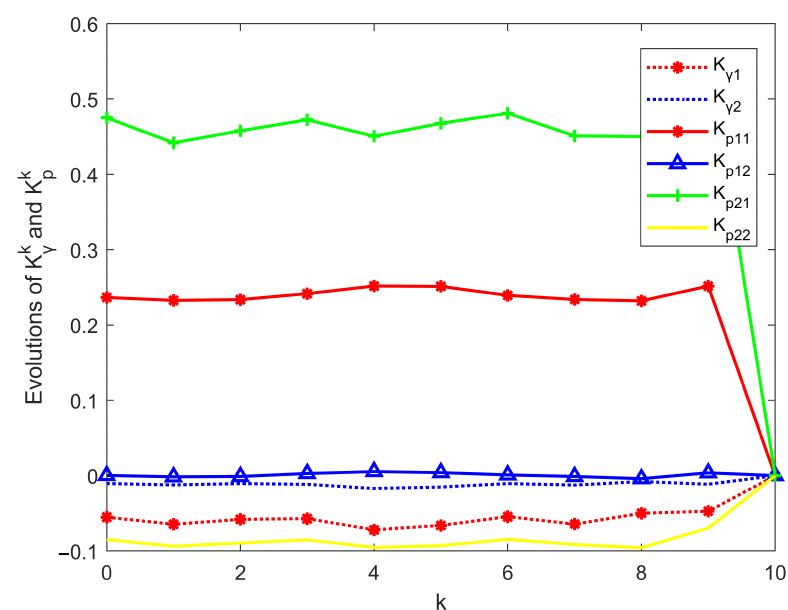
Figure 2. Convergence of K k γ and K k p